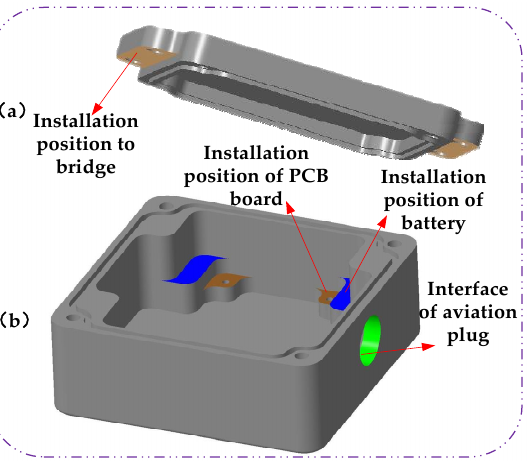
Figure 9. Schematic diagram of the packaging box of wireless acceleration sensor.